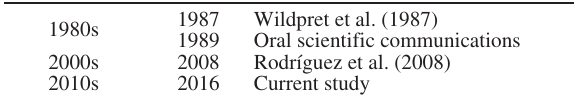
Table 1. – Cartographic sources on the distribution of Cystoseira abies-marina in Gran Canaria